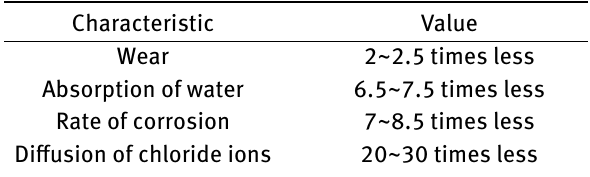
Table 2: The durability of RPC vs. HPC